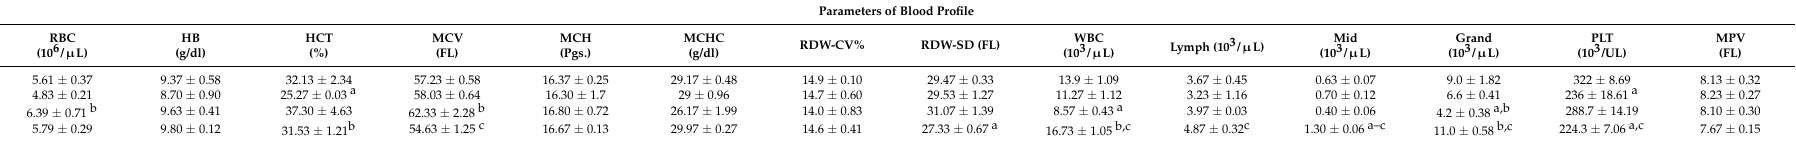
Table 3. Effect of pomegranate peel and garlic powder separately or in combination on blood profile of does.